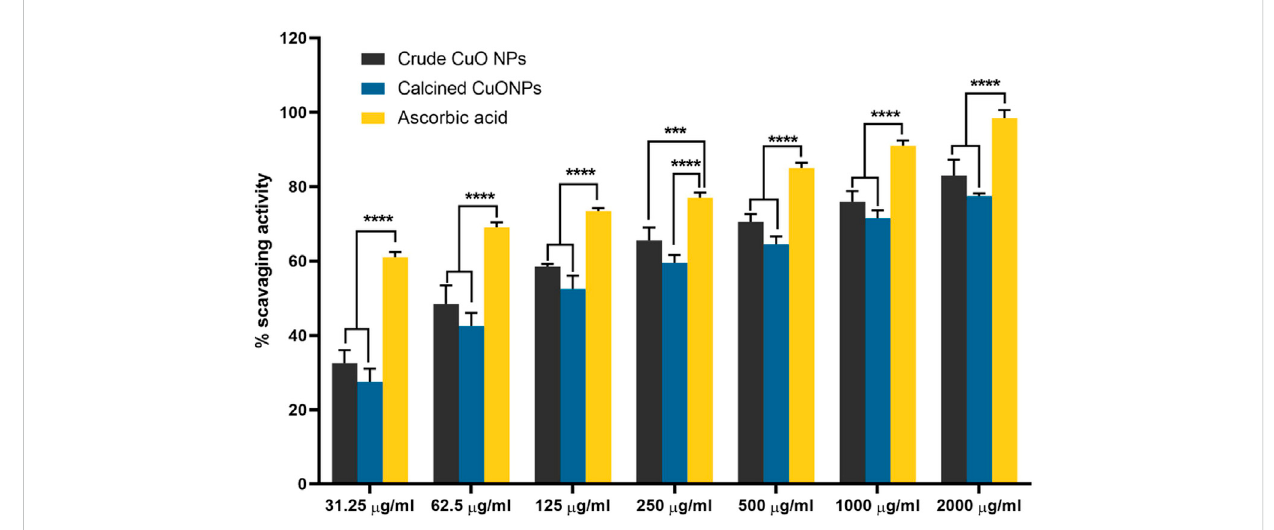
The antioxidant activity of biogenic CuONPs at different concentrations. Ascorbic acid was used as a standard. **** p < 0.0001 indicate signi fi cant difference with ascorbic acid.